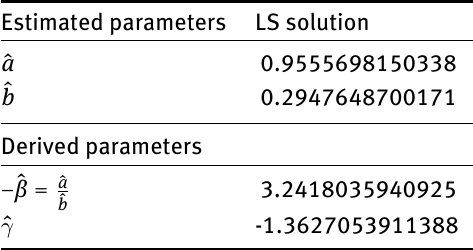
Table 3: Direct LS solution - line fit 2D